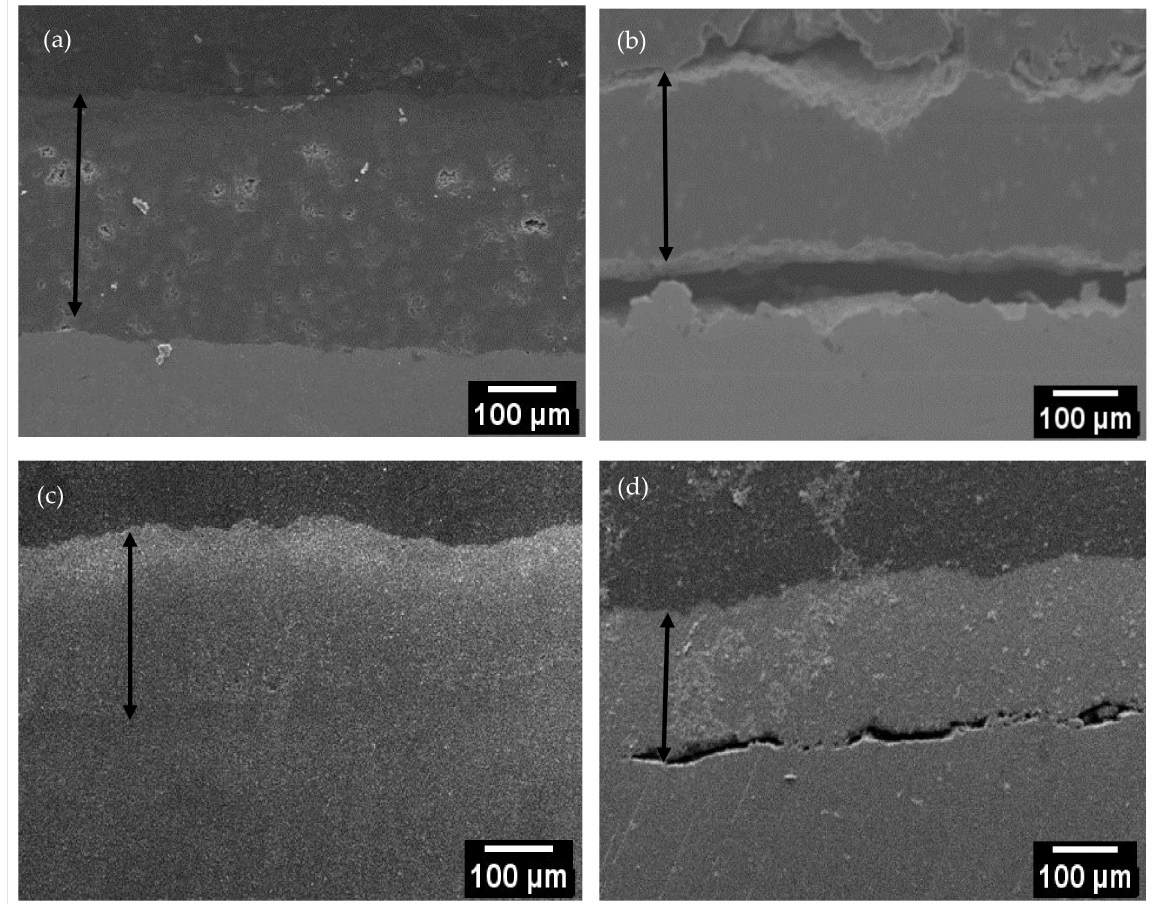
Figure 2. Cross-sectional microstructure of titanium dioxide coating on C1020 ( a ) at RT and ( b ) annealed at 400 ◦ C. AA1050 ( c ) at room temperature and ( d ) annealed at 400 ◦